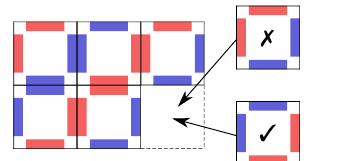
Figure 1. Periodic tiling composed of 2 Wang tiles over 2